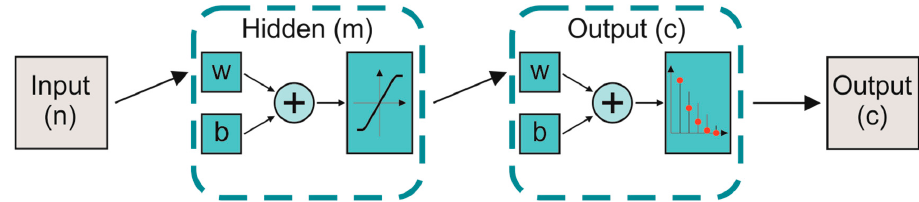
Figure 3. Scheme of an artificial neural network (ANN) classification. n, m, and c represent the number of input, hidden, and output layers, respectively. w and b represent the weights and biases related to the interconnections among neurons.